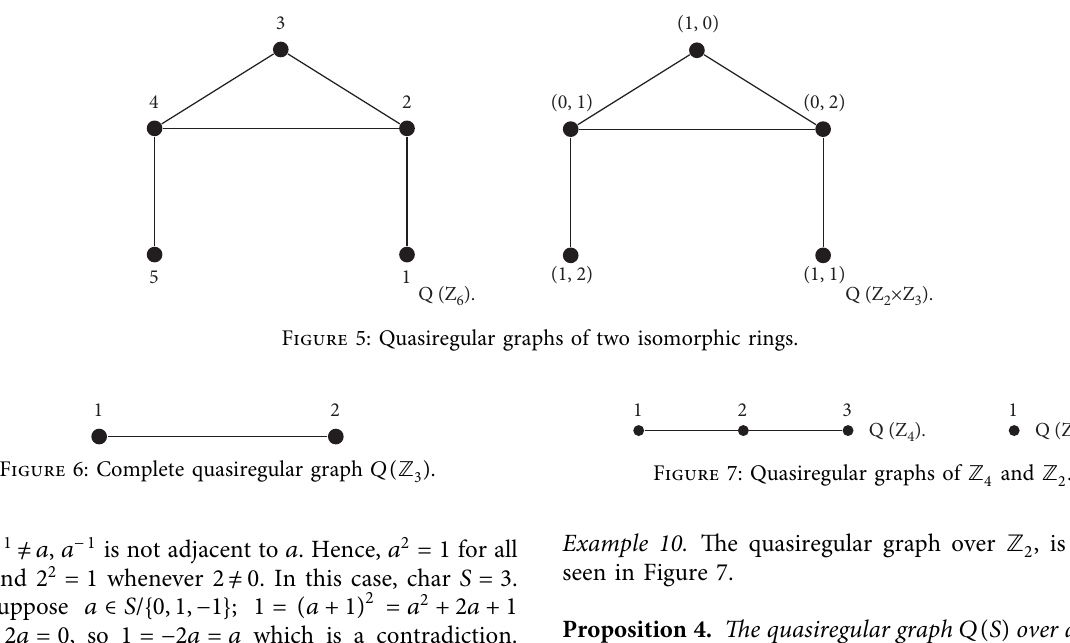
) . Figure 7: Quasiregular graphs of Z 3